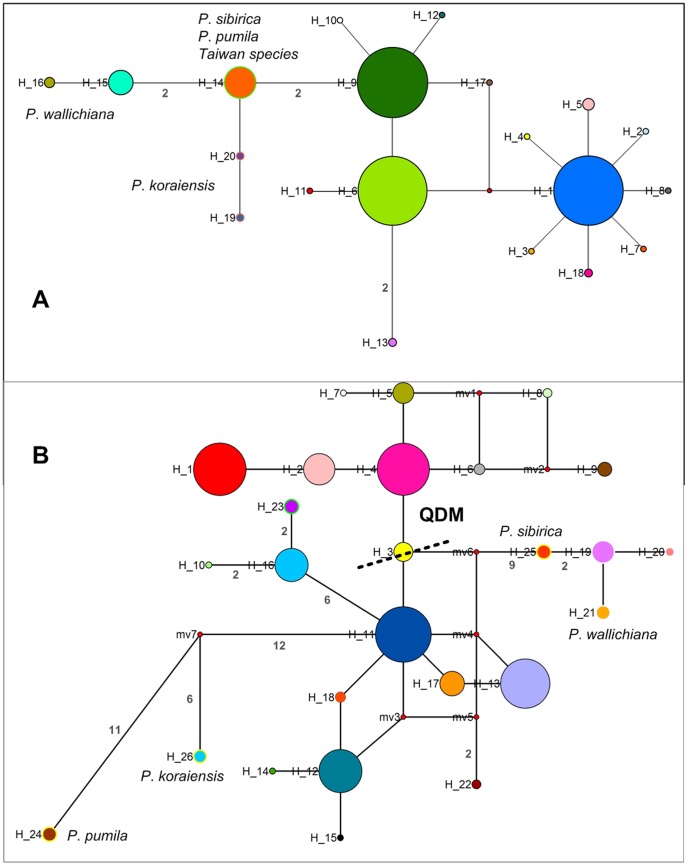
NETWORK-derived genealogical relationship of chlorotypes (A) and mitotypes (B).The sizes of the circles in the network are proportional to the observed frequencies of the haplotypes. The number of mutational steps larger than one is shown next to the solid line between haplotypes.